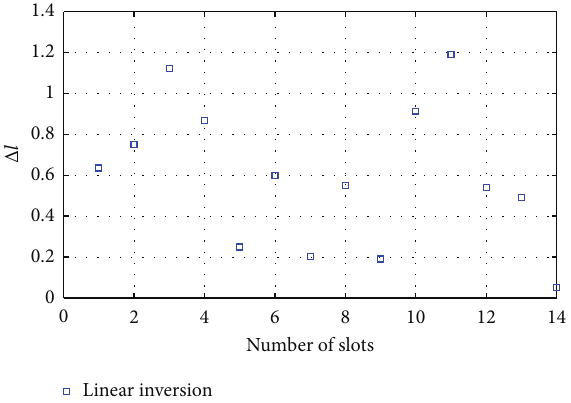
Figure 13: ℓ 2 minization: the difference of excitations in the absence and the presence of failures (slots 3 and 11